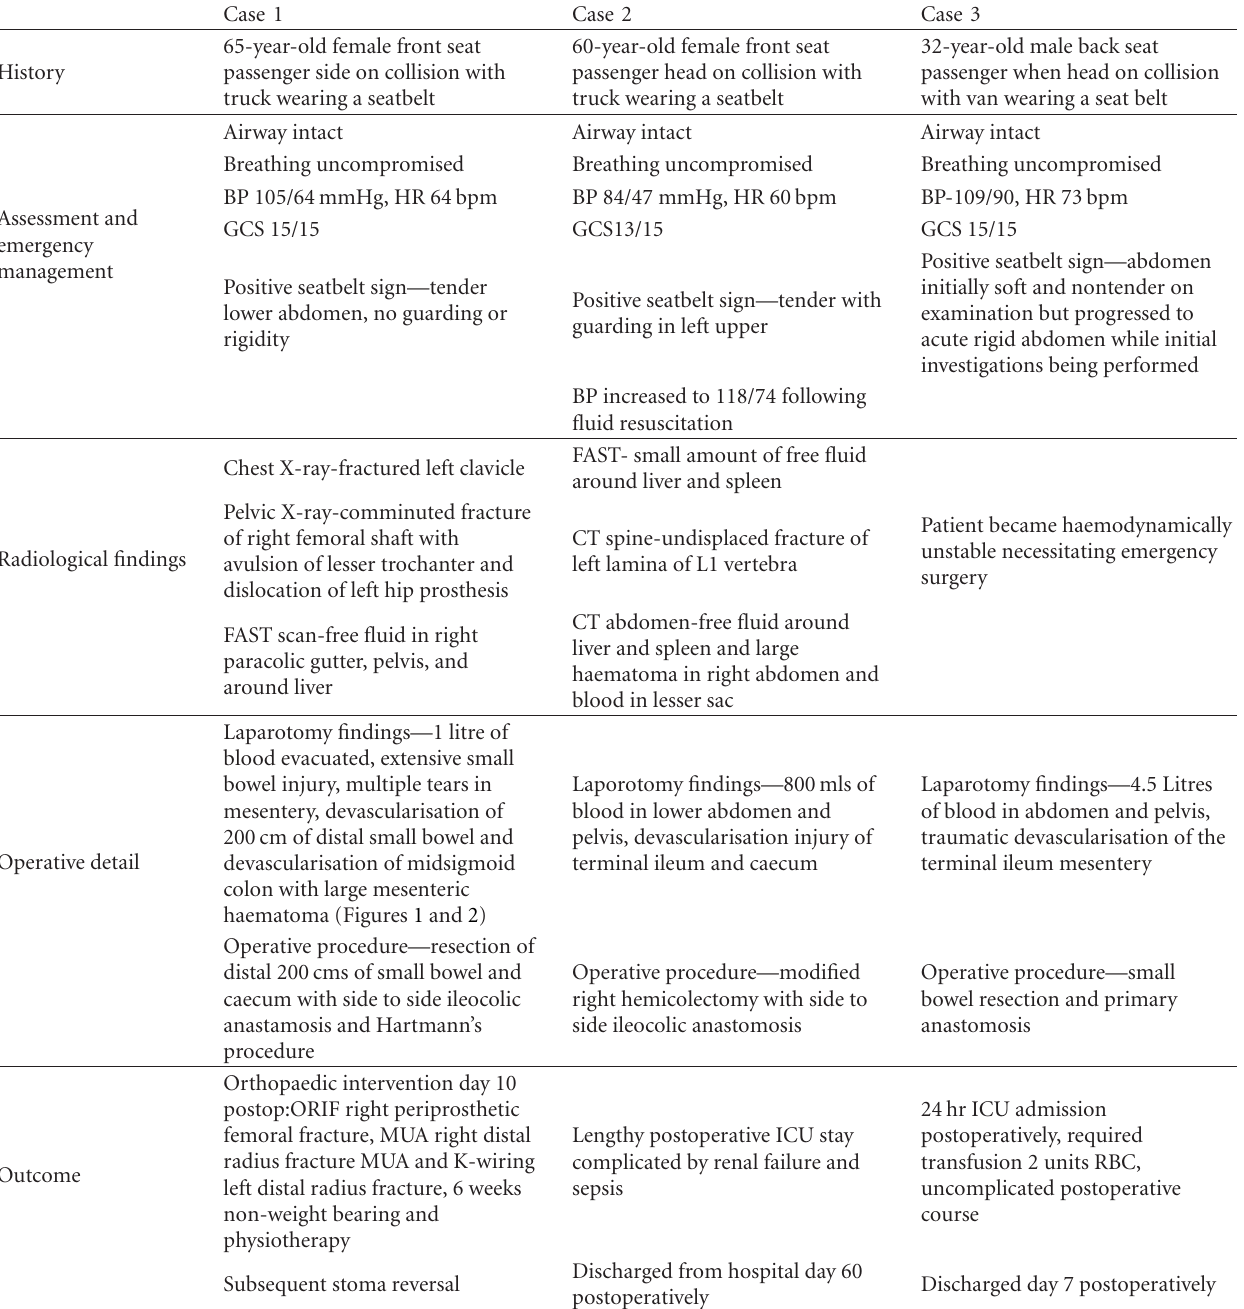
Table 1: Clinical Cases—presentation, investigation and